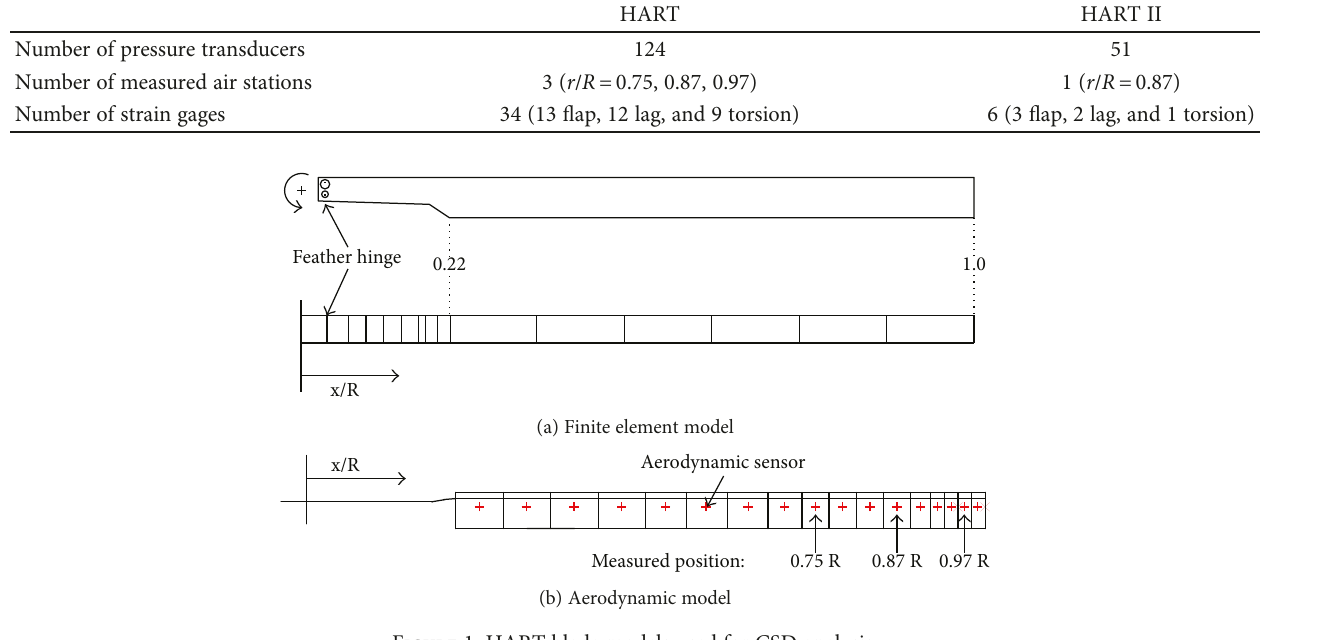
Figure 1: HART blade models used for CSD analysis.